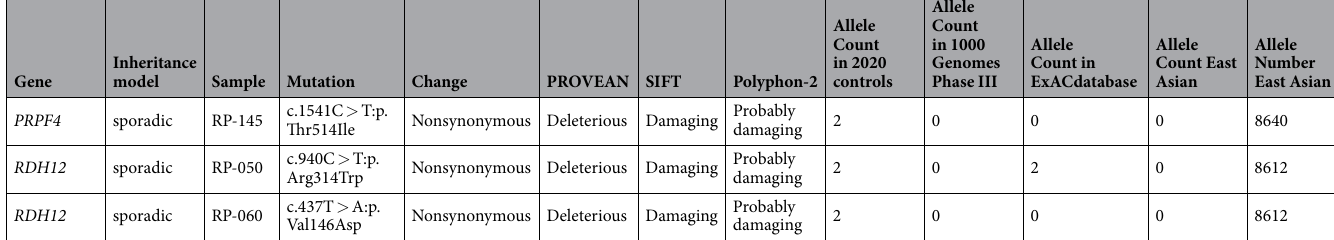
Table 2. Three candidate mutations with minor allele frequencies less than 0.001 in control samples in the 3of the 98 small Han Chinese families with RP. The mutations were filtered with the following multiple-step bioinformatics analysis: 1) the SNPs and short indels in the exome region were filtered against data from 1000 genome, dbSNP135-common, ExAC and unrelated individuals of 2020 in-house non-RP controls, removing minor allele frequency (MAF) values that were greater than 0.001; 2) excluded non-coding variants without altering splicing sites; 3) excluded the synonymous variants without altering splicing sites in the genes; 4) excluded missense variants predicted to be Neutral/Tolerated /Benign by PROVEAN, SIFT and